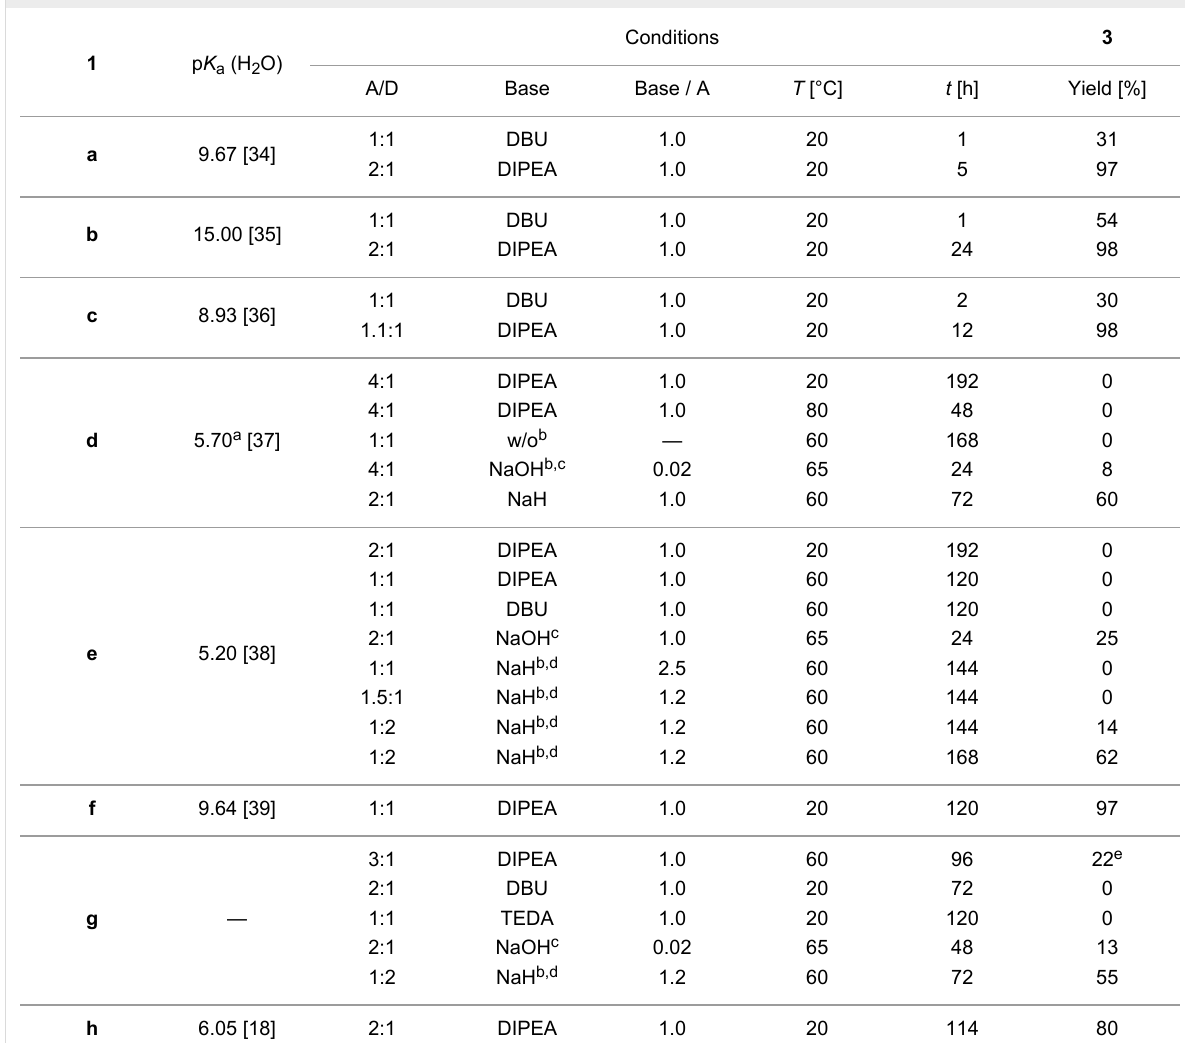
Table 1: Optimised conditions of Michael-type addition of azoles of broad-scale acidity 1a–h to methyl acrylate (2) , physical properties and yields of the products 3a–h .